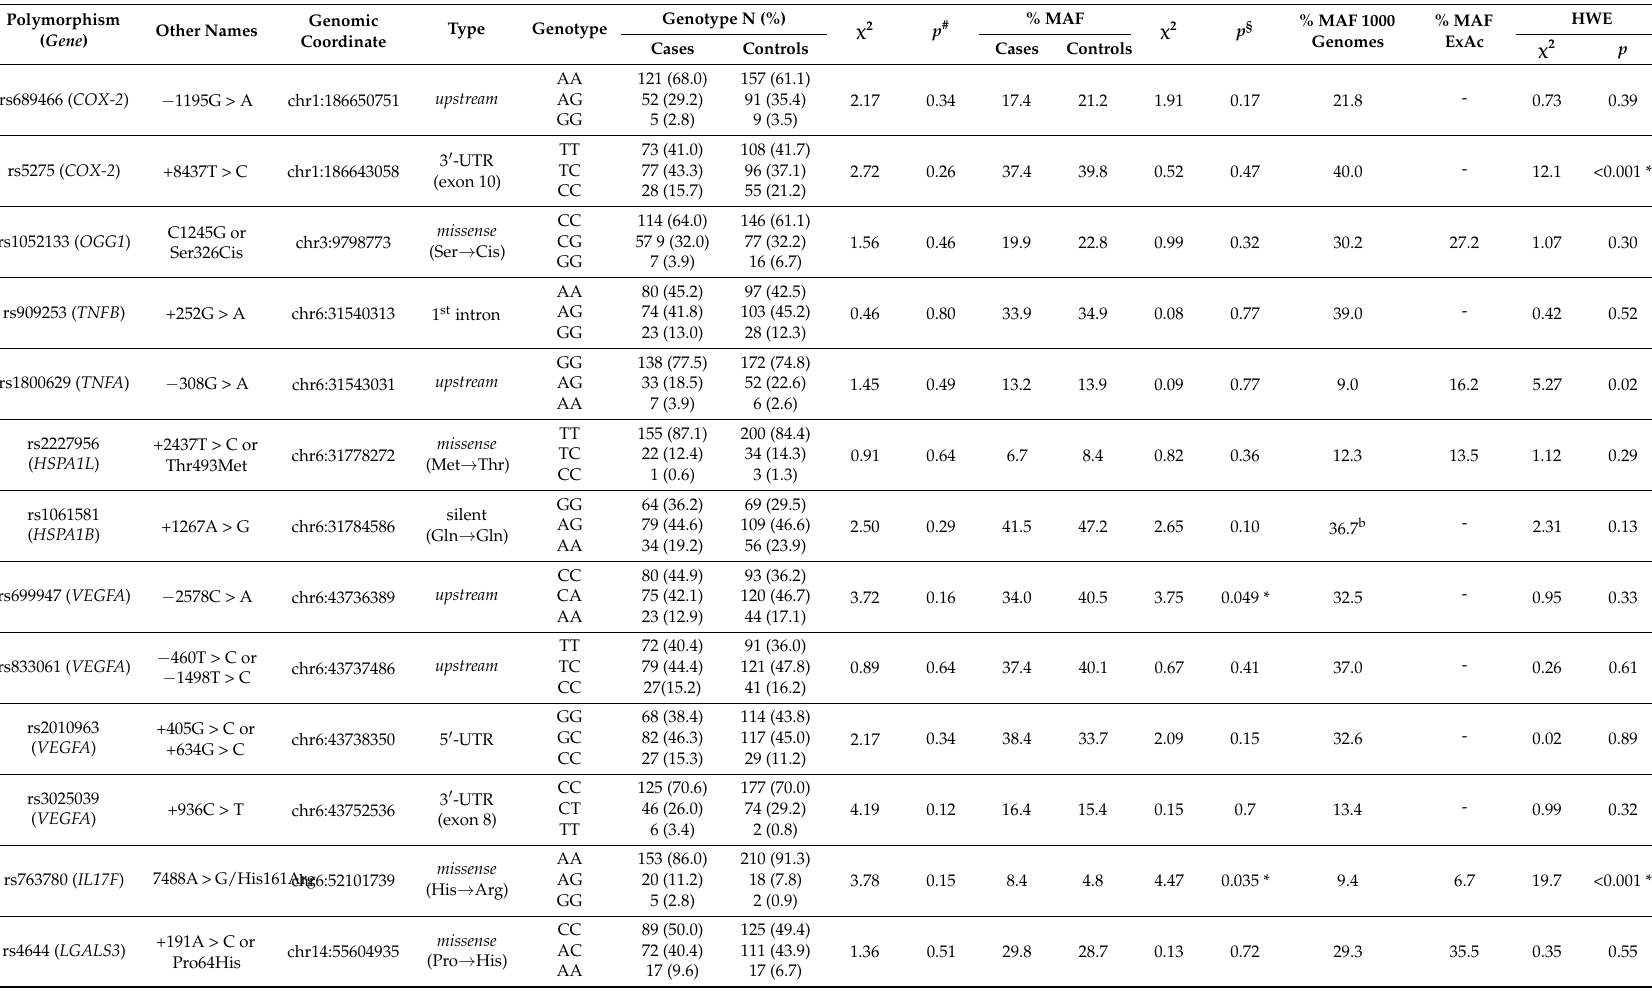
Table 1. Description of the selected polymorphisms, comparison of their genotype/allele frequencies between cases with gastric cancer (N = 178) and control individuals (N = 262), description of the allelic frequencies available in public database and results of the Hardy-Weinberg